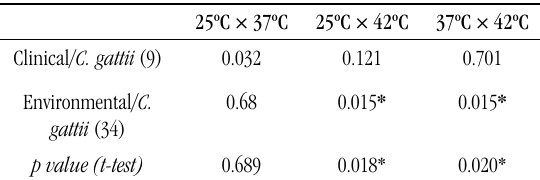
tABLE 5 – Statistical correlation between mean concentration of Cryptococcus gattii isolates under thermotolerance and the differences in test temperatures